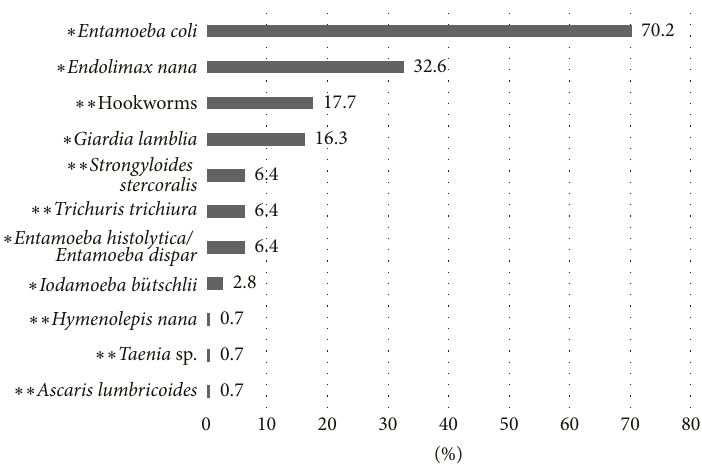
Figure 2: Distribution of subjects ( 𝑛 = 141 ), by enteroparasite species detected ( ∗ protozoans; ∗∗ helminths).